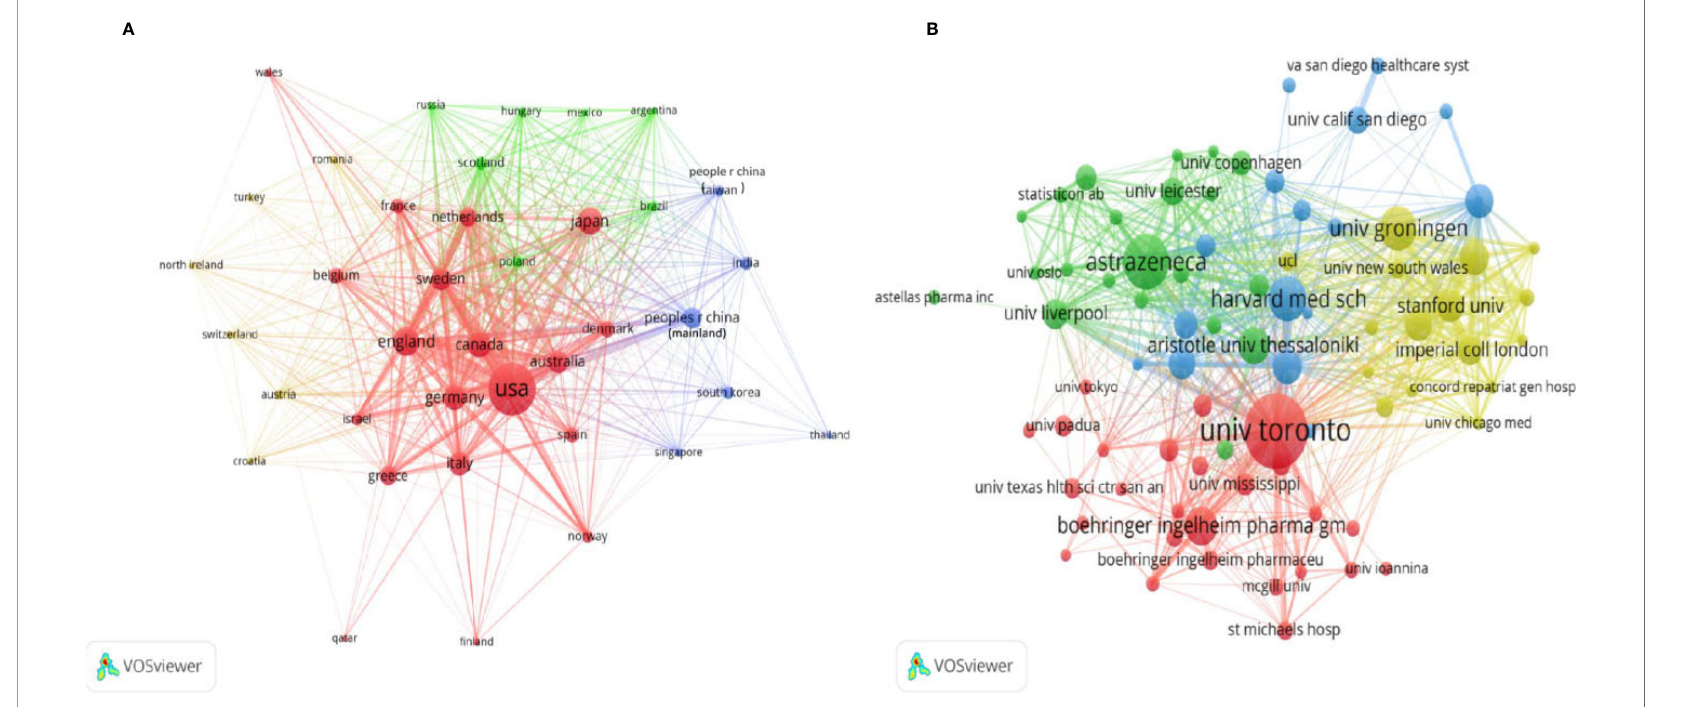
FIGURE 2 | VOSviewer network visualization map of country/regions and institutions involved in SGLT2 inhibitors in cardiovascular research. (A) Collaboration analysis of countries/regions. Of the 76 countries/ regions, 38 had at least 10 publications. (B) Collaboration analysis of institutions. Of the 2,757 institutions, 81 had at least 10